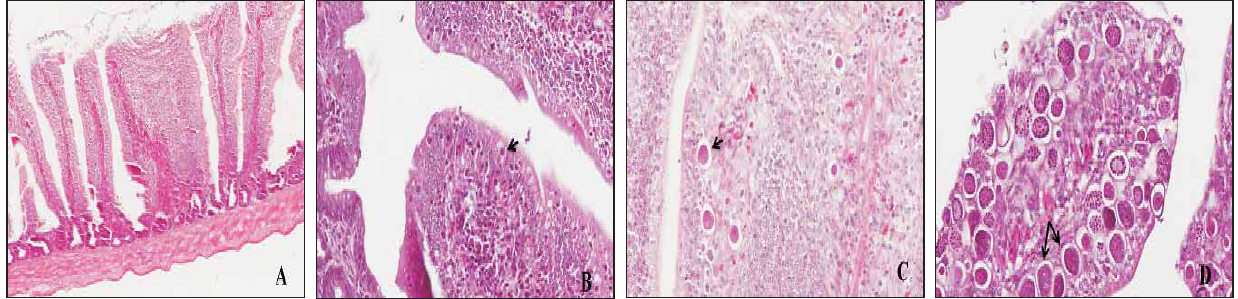
Figure-4: Comparative histopathological observations of chicken intestine post infection (PI) with (1.0x10 sporulated oocyst/chick): oocyst's developmental stages in the cecum cells (AXIO ZEISS Imager M2 microscope, using AxioCam HRc). (A) Photomicrograph of a cecum from broiler chicken of the control. Cecum of non infected: normal tissues can be seen (H & E, (B) Photomicrograph of a cecum from a broiler chicken inoculated with a at 72 h PI: gametocytes in the cecum cells (H&E) x200; (C) Photomicrograph of a cecum from a broiler chicken inoculated with a at 120 h PI: Numerous intracellular schizonts containing merozoites (arrow) can be seen with severe submucosal hemorrhage. (H&E). x400; (D) Photomicrograph of a cecum from a broiler chicken inoculated with a at 144 h PI: infected cells with immature macrogametocytes in the border epithelial cells of cecum. (H&E). x400. Arrow indicates different forms of the intracellular parasite.